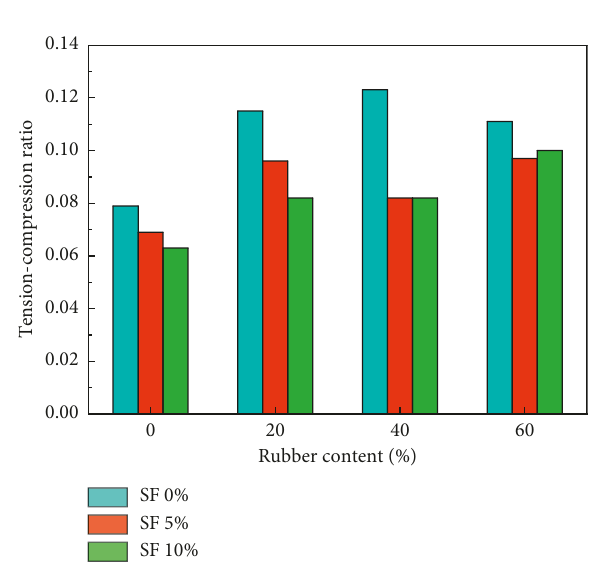
Figure 8: Relationship between splitting tensile strength and compressive strength on day